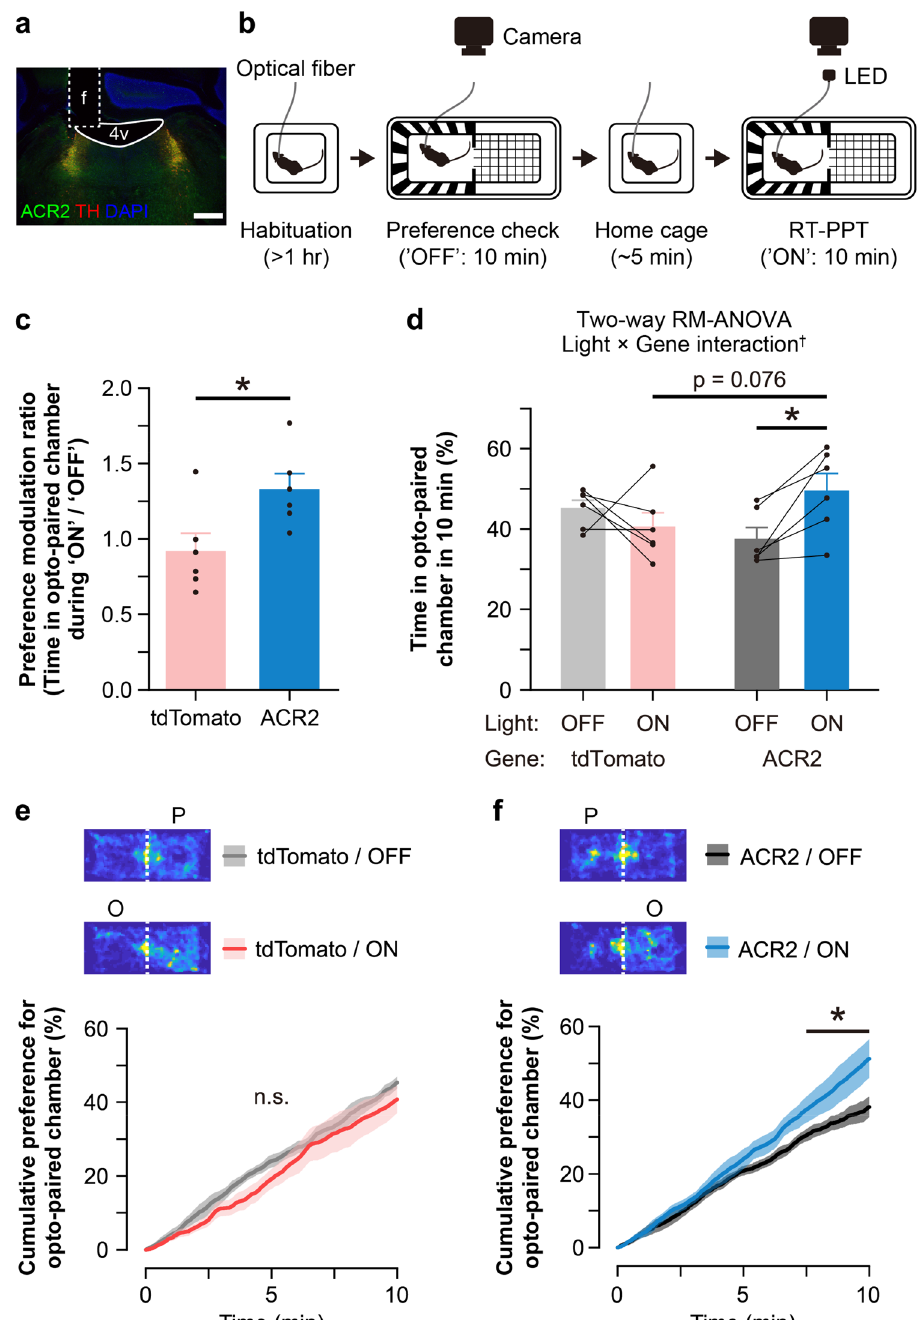
Figure 6. In vivo inhibition of LC-NA neuron-induced place preference. ( a ) Representative brain slice image showing the position of the implanted fiber above the LC. f, fiber tract; 4v, fourth ventricle. Green: ACR2, Red: TH, Blue: DAPI, scale bar: 500 μm. ( b ) Schematic of real-time place preference test (RT-PPT). After an animal was habituated with an optic fiber for > 1 h in the home cage (Habituation), the place preference at baseline was examined for 10 min in the two-chamber apparatus (Preference check, ‘OFF’). Then, the animal was temporarily placed back into the home cage and preference analysis was performed after ~ 5 min (Home cage). The opto-paired chamber was determined to be the non-preferred chamber, and RT-PPT was performed for 10 min (RT-PPT, ‘ON’). ( c ) Preference modulation ratio of control animals expressing tdTomato and animals expressing ACR2. *p < 0.05 (tdTomato, n = 6 animals; ACR2, n = 6 animals, Welch’s t-test). ( d ) Time spent in the opto-paired chamber during 10 min, or the preference, at baseline (OFF) and RT-PPT (ON). † p < 0.05, significant interaction shown in two-way repeated measures (RM) ANOVA between factors ‘light’ and ‘gene’. *p < 0.05, ‘p = 0.076’, post hoc Tukey’s test. tdTomato, n = 6 animals; ACR2, n = 6 animals. ( e and f ) The top heat maps show the time spent in the two-chamber cage for a representative animal from each group. P, preferred chamber; O, opto-paired chamber. The line graph shows the cumulative place preference over 10 min. n.s., not significant (n = 6 animals, Tukey’s test for every 10 s, OFF vs. ON); *p < 0.05 (n = 6 animals, Tukey’s test for every 10 s, OFF vs. ON). Line, mean; shadow, standard error of the